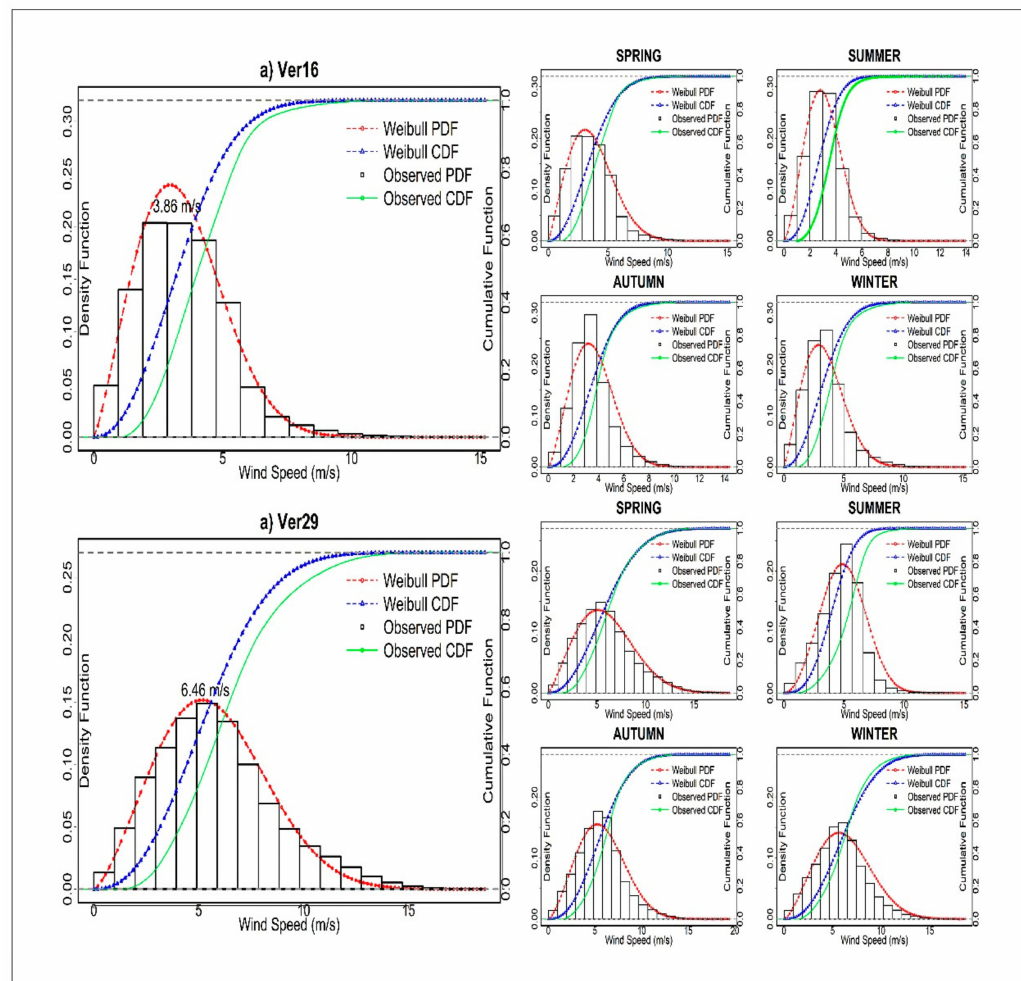
Figure 5. Annual and seasonal Weibull distributions for the state of